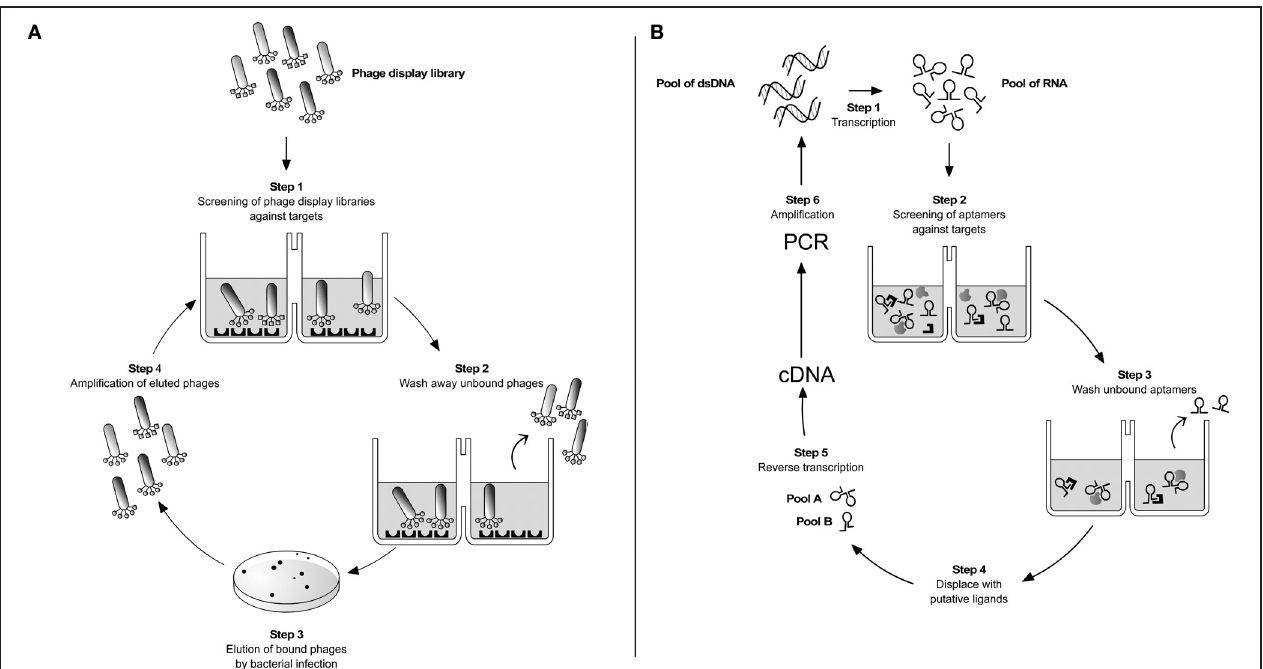
FIGURE 1 | Parasite targetting by combinatorial techniques. (A) Phage display. A phage library displaying potential ligand proteins on their surface is exposed to an immobilized target (step 1). After washing away unbound phages (step 2), binders are eluted by Escherichia coli infection and plated on LB-agar (step 3). Clones are then amplified producing a phage mixture that is enriched with relevant (i.e., binding) phage (step 4). The repeated cycling of these steps is referred as “panning”. At the end of 3–4 rounds of panning the enriched phage population is recovered by infection of a suitable bacterial host and sequenced to identify the interacting peptides or protein fragments. (B) SELEX. It is based on a stretch of single-stranded nucleic acid, which can be RNA or single-stranded DNA (ss-DNA). These are chemically synthesized to have a random stretch usually from 8 to 40